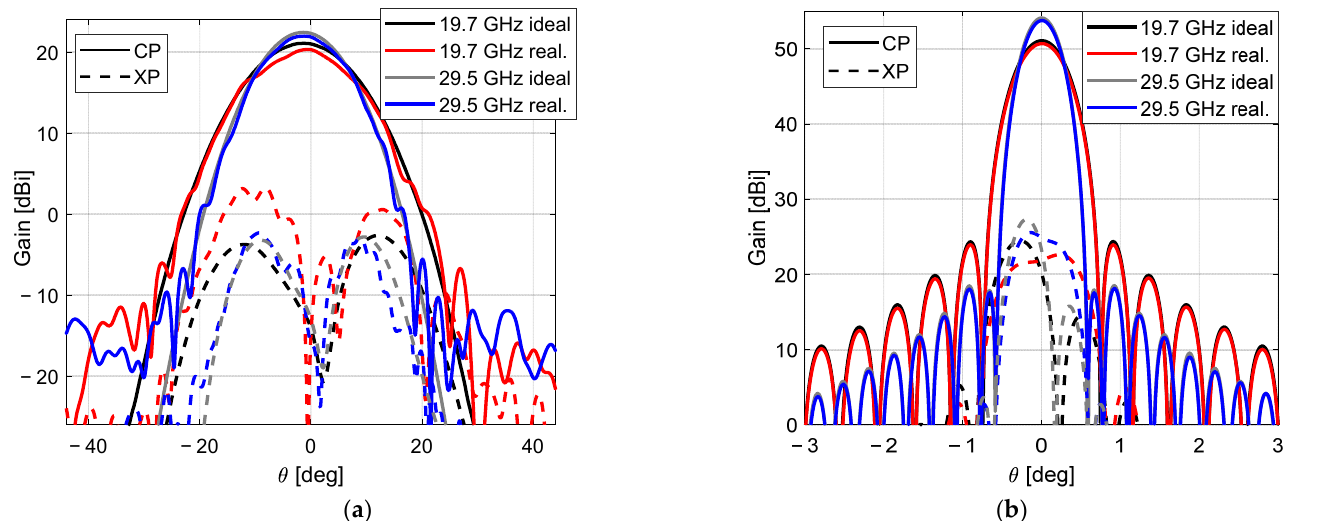
Figure 12. Simulated radiation patterns at 19.7 and 29.5 GHz in the azimuth plane of the ideal and realized antenna components. ( a ) Subreflectarray for H polarization, ( b ) main reflectarray for right-handed circular polarizations (RHCP).